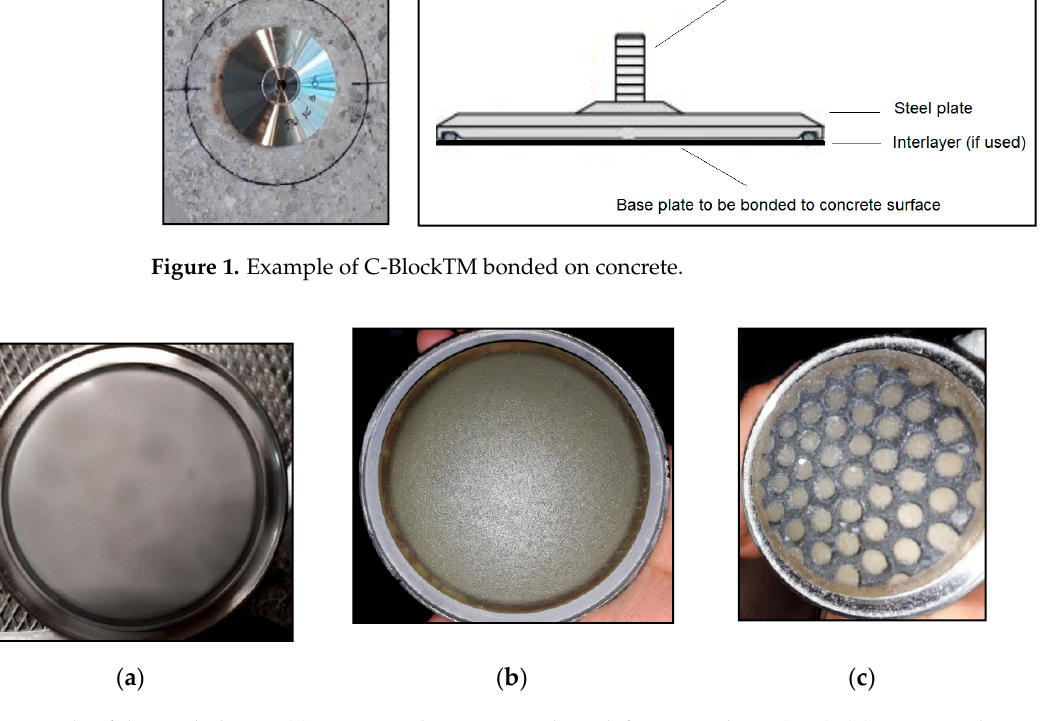
Figure 2. Bottom side of the steel platess: ( a ) type A with no intermediate deformation layer (IDL); ( b ) type B with a simple IDL; ( c ) type C with a cellular IDL.